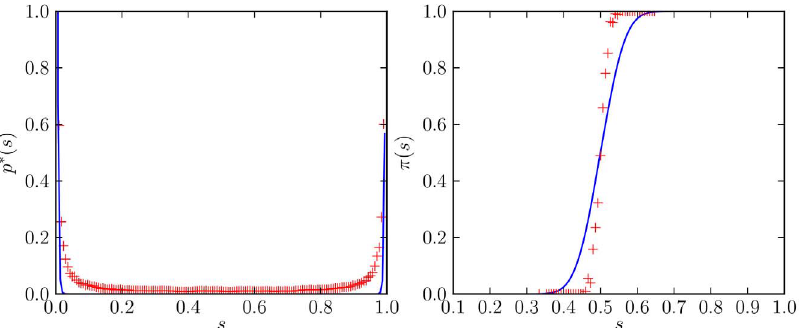
Figure 3. Stationary probability distribution and splitting probability for a virtual swarm. (left) Stationary probability distribution p (cid:2) ( s ) as estimated from the simulation output (red markers) and computed from the FPE coefficients [Eq. (56) in Appendix 1.2]. (right) Splitting probability p ( s ) , as estimated directly from the simulation output [cf. Eq. (53) in Appendix 1.2] (red markers) and computed using the integrated stationary distribution [Eq. (54) in Appendix 1.2] (blue curve). Simulation parameters are given in Table 1.